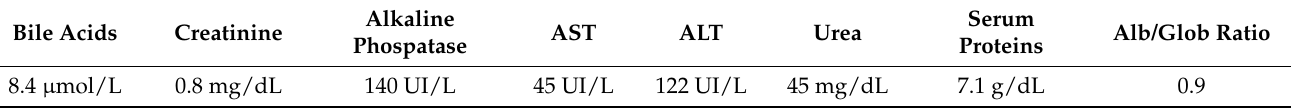
Table 3. Dog 3 biochemical parameters.